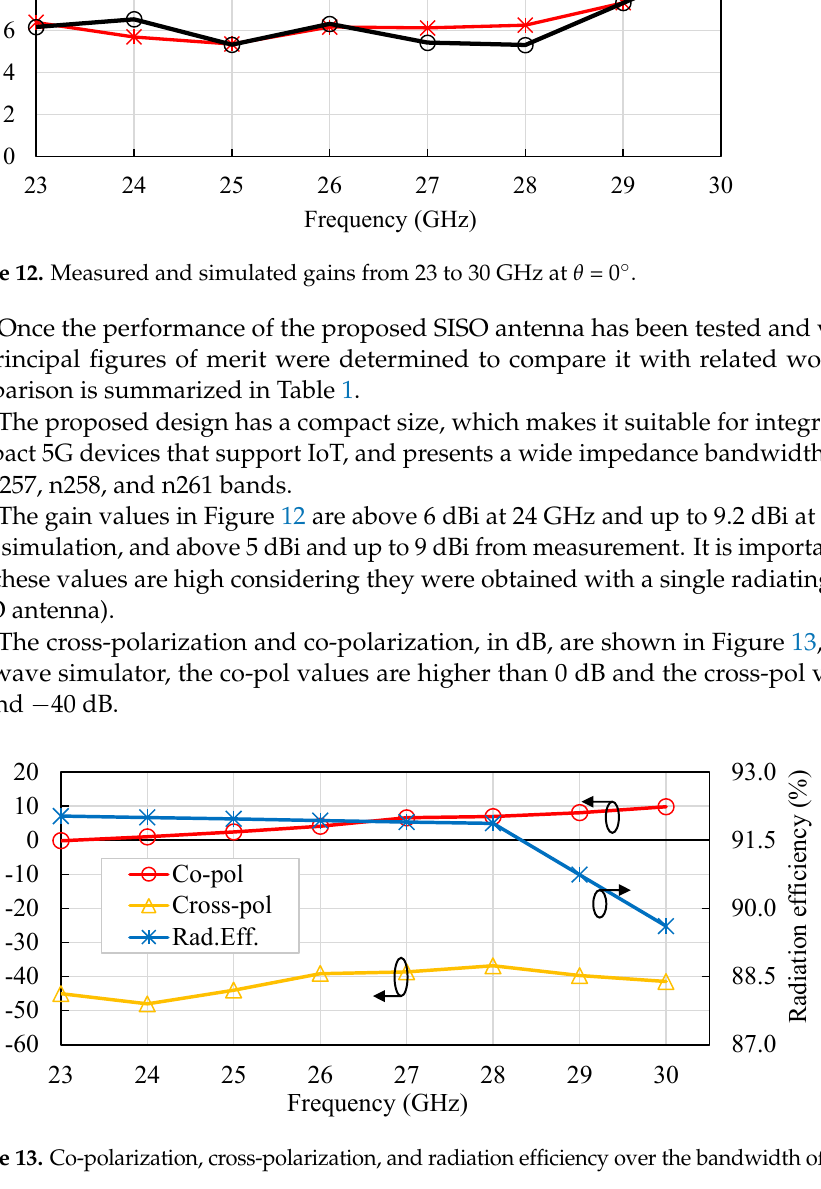
Figure 12. Measured and simulated gains from 23 to 30 GHz at θ = 0°.